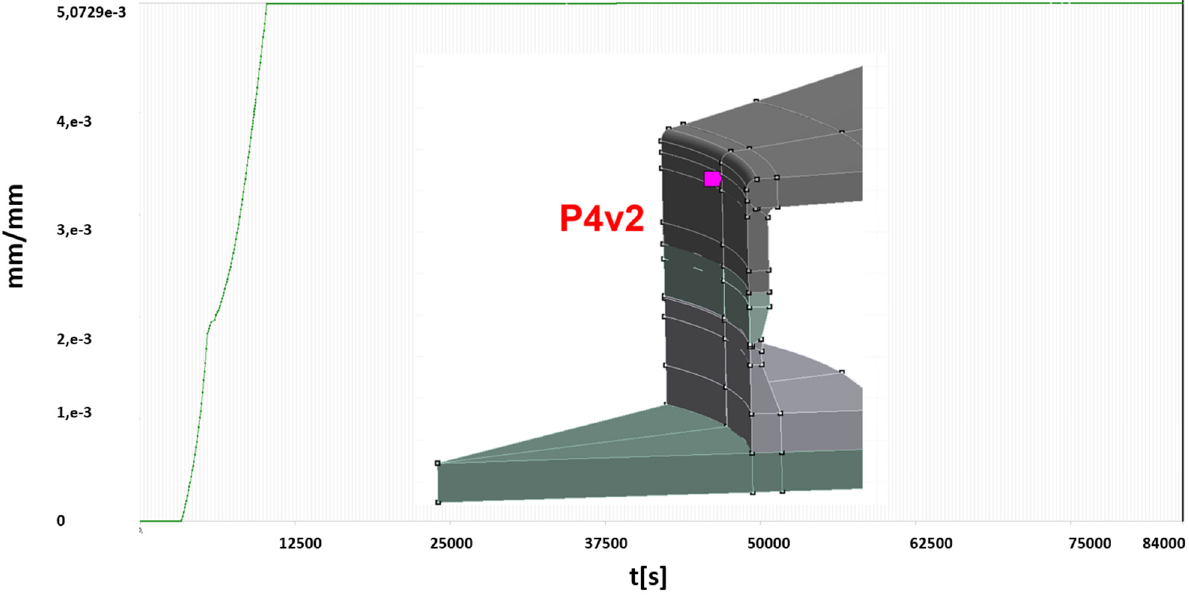
Figure 16. Generalized plastic strain for the entire loading scheme—point P4v2.